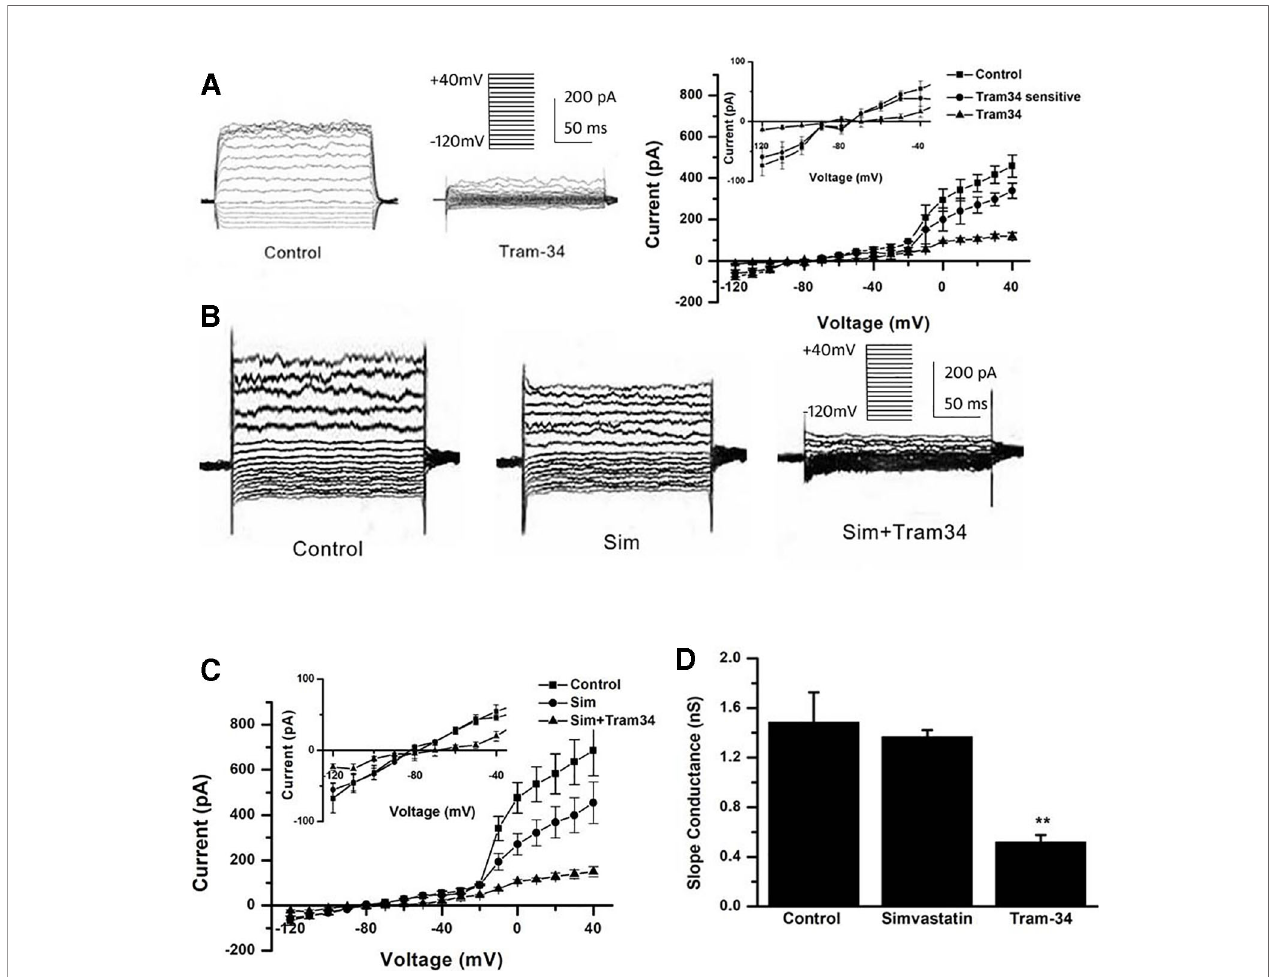
FIGURE 4 | Effects of simvastatin on KCa3.1 current intensity change in THP-1 cells measured by whole-cell clamp patch. (A) The THP-1 cells were held at − 40mV and received the test potentials from − 120 to +40 mV; the KCa3.1 currents were detected by using an electrode with 1 µM free Ca 2+ . The currents were blocked by 1 m M Tram-34. (B) The representative current traces of KCa3.1. Simvastatin treatment had no signi fi cant effect on the current intensity of KCa3.1. (C) Average current density-voltage relationships before and after application of 10 µM simvastatin and 1 µM Tram-34 was indicated (n = 4 for each group). (D) The slope conductance between − 120 mV and − 40 mV was measured by fi tting the curve with linear equation. Data was summarized from 4 THP-1 cells, ** P < 0.01, vs. normal